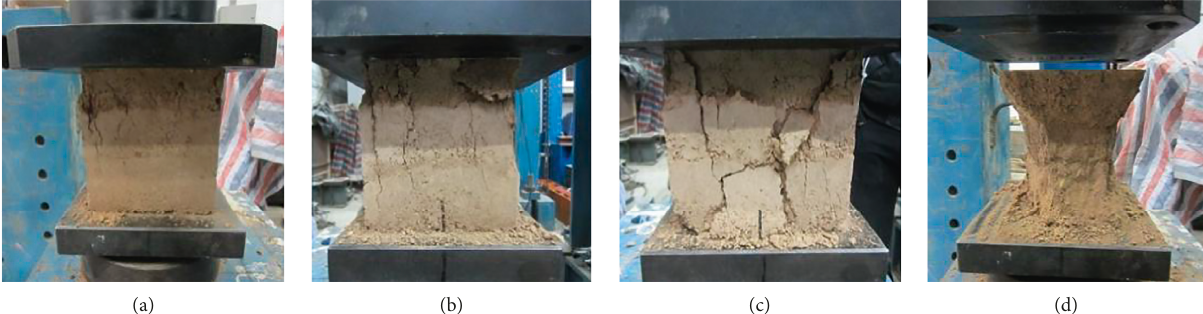
Figure 3: Progress of a loess cube compressive strength test. (a) Loading. (b) Cracking. (c) Damaged. (d) Completely destroyed.